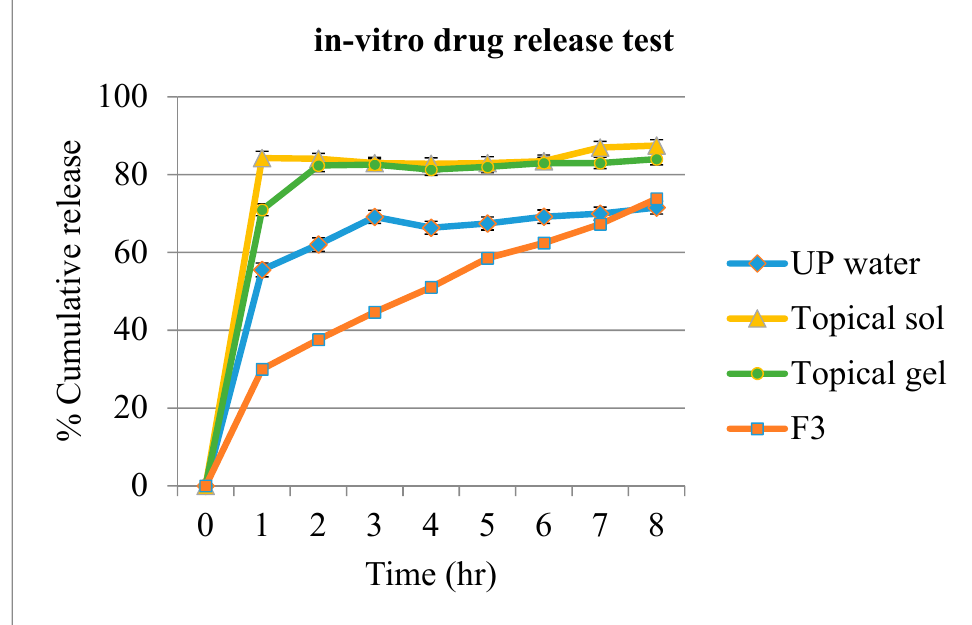
Figure 3. Presentation of cumulative release (%) of clindamycin from different formulations (Data presented as mean ± SD; n = 3).